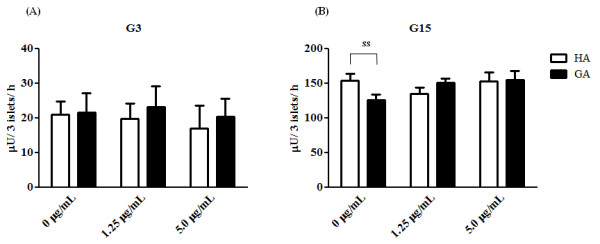
Effect of GA on insulin secretion. Rat islets were incubated for 24 h at 37°C with 0.1 mg/mL HA (white bar) or GA (black bar) under G3 (A) or G15 (B) conditions. Labeling of the X-axis represents the dose of anti-human GA neutralizing antibody, A717. Each bar represents the mean plus SEM of 5 separate experiments, each with n = 4. ss; statistically significant.